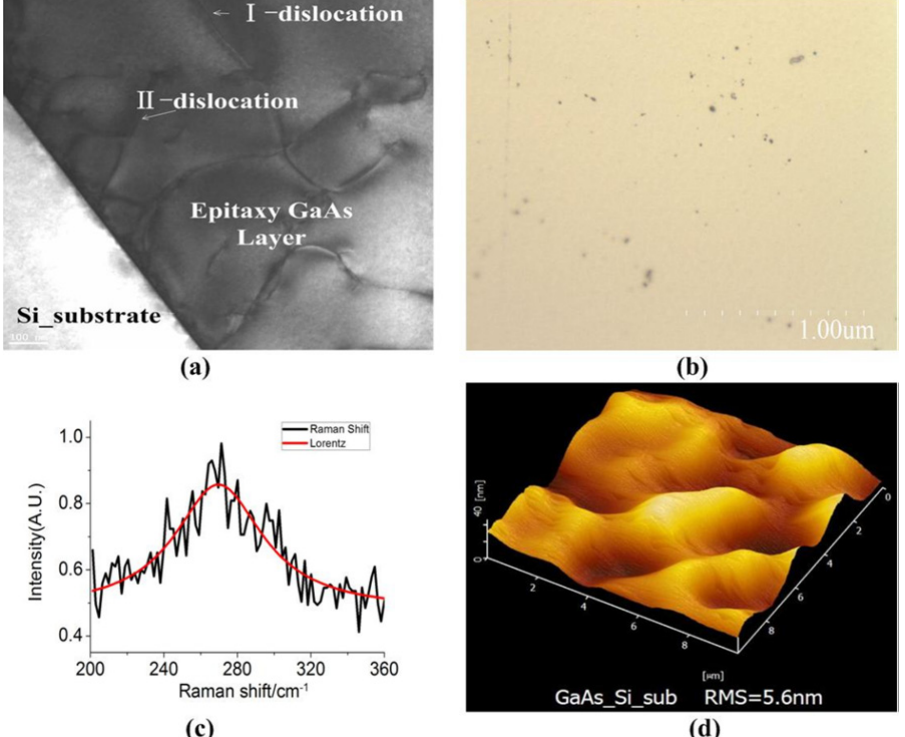
Figure 2. Wafer test: ( a ) the cross-section TEM image; ( b ) the SEM image of etch pit of dislocation; ( c ) Raman spectra; and ( d ) the AFM